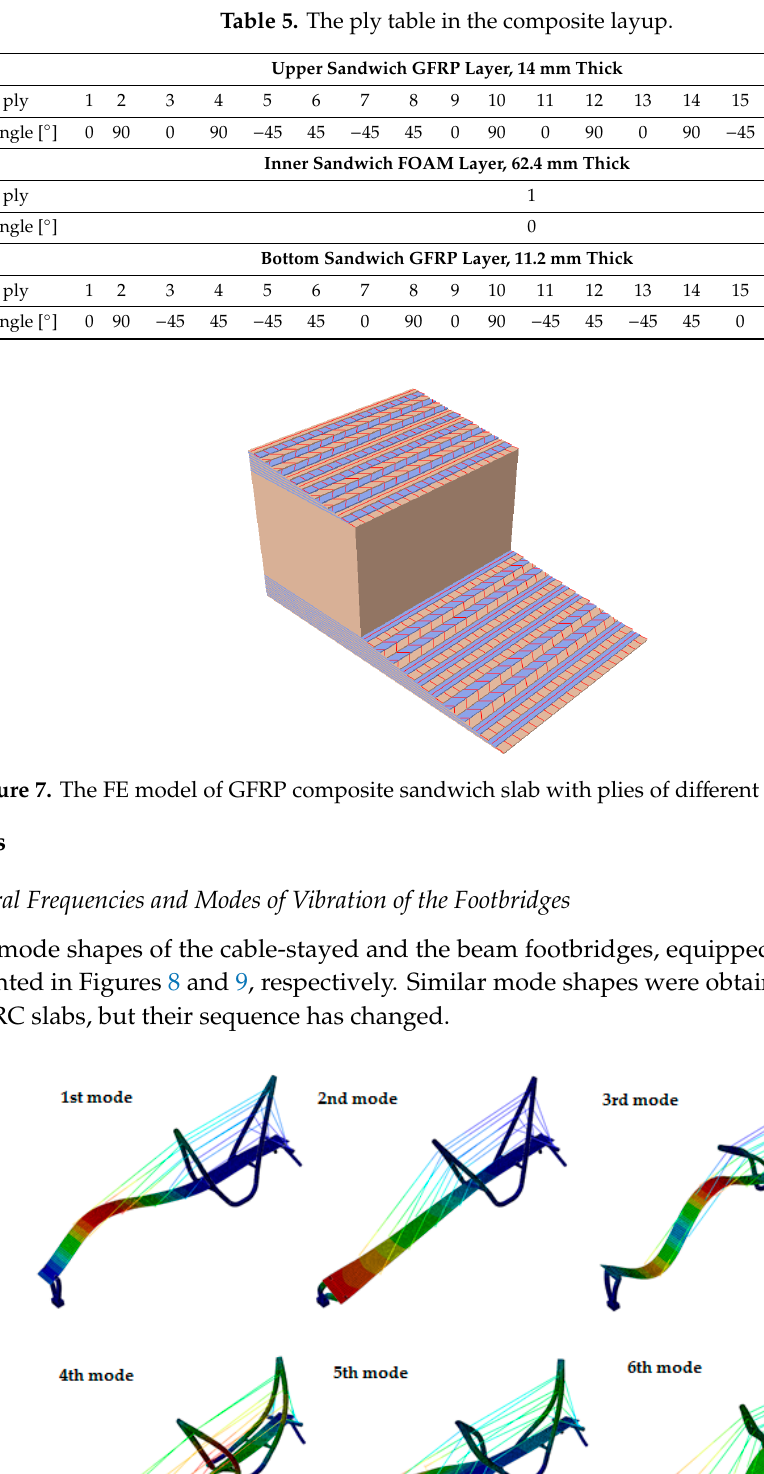
Table 5. The ply table in the composite layup.